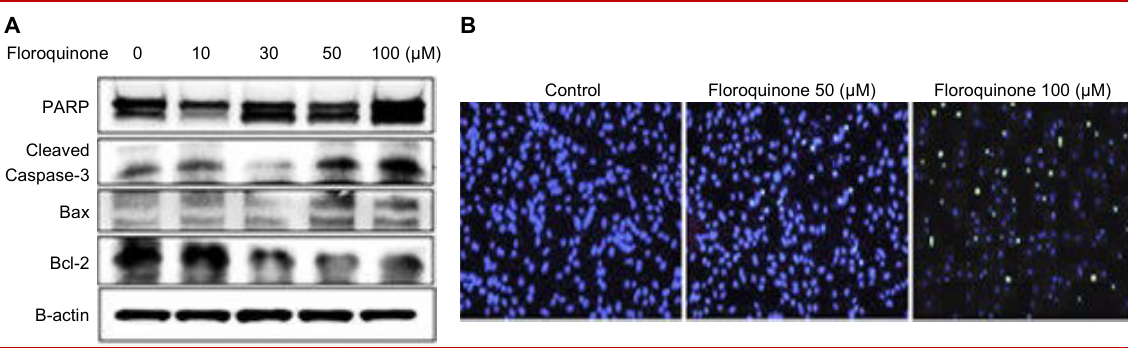
Figure 2: Floroquinone treatment of HOTHC cell lines induces apoptosis. (A) The cells were incubated with floroquinone for 48 hours and then analyzed by western blot assay for expression of apoptosis factors. (B) The cells after treatment with floroquinone were subjected to DAPI staining for analysis of apoptotic changes (magnification, of the breast cancer cells was inhibited on treatment with floroquinone. The inhibition of migration potential by floroquinone in breast cancer cells was associated with the suppression of HIF-1 α and VEGF expression.